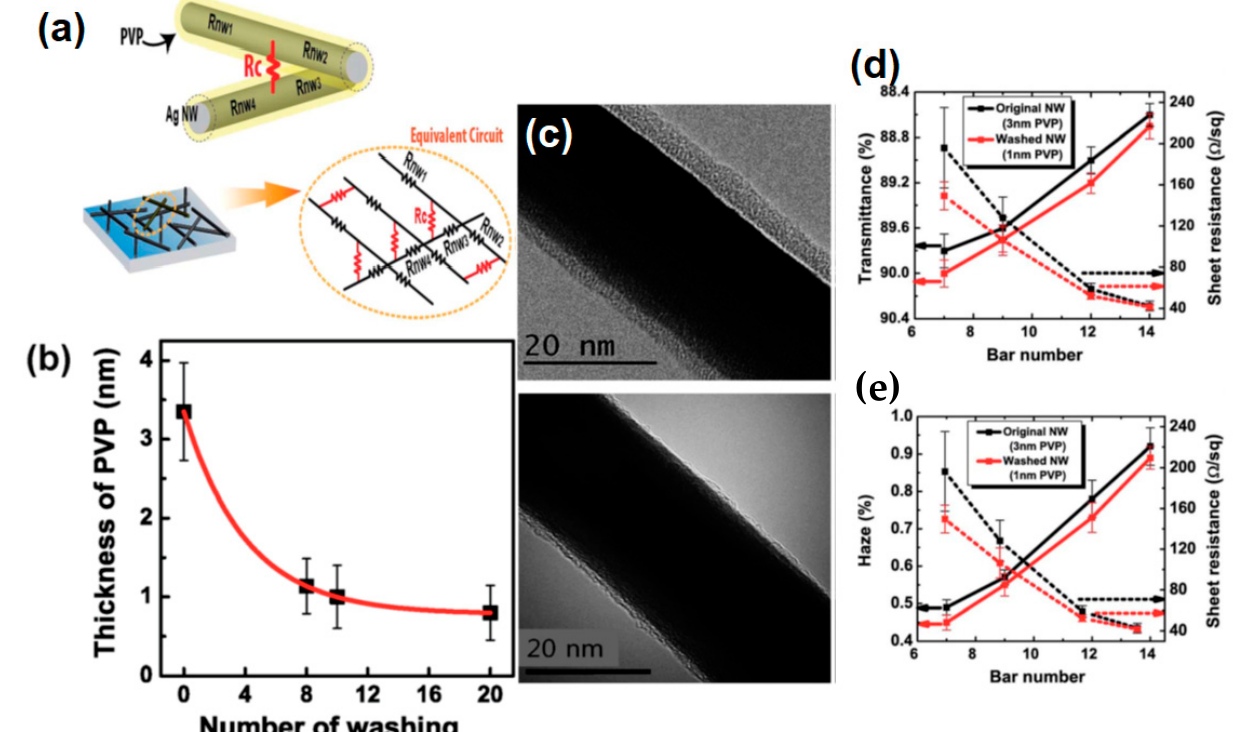
Figure 17. ( a ) Conceptual illustration of contact resistance and nanowire resistance, and the equivalent circuit of AgNW network which can be used for Monte Carlo simulation. ( b ) Average thickness measured for the PVP capping layer on the AgNWs with different numbers of repetitions of the washing process. ( c )TEM image of an as-synthesized PVP-capped AgNW and the same NW after washing 20 times with DI water. ( d ) Transmittance versus bar number of a Mayer rod with error bars ( e ) Haze versus bar number of a Mayer rod with error bars (the values of R S of the corresponding samples are plotted together in order to indicate the different areal coverage of the AgNW networks that were coated with different bar numbers of the Mayer rod). (adapted from [208] with permission from Royal Society of Chemistry, 2016)